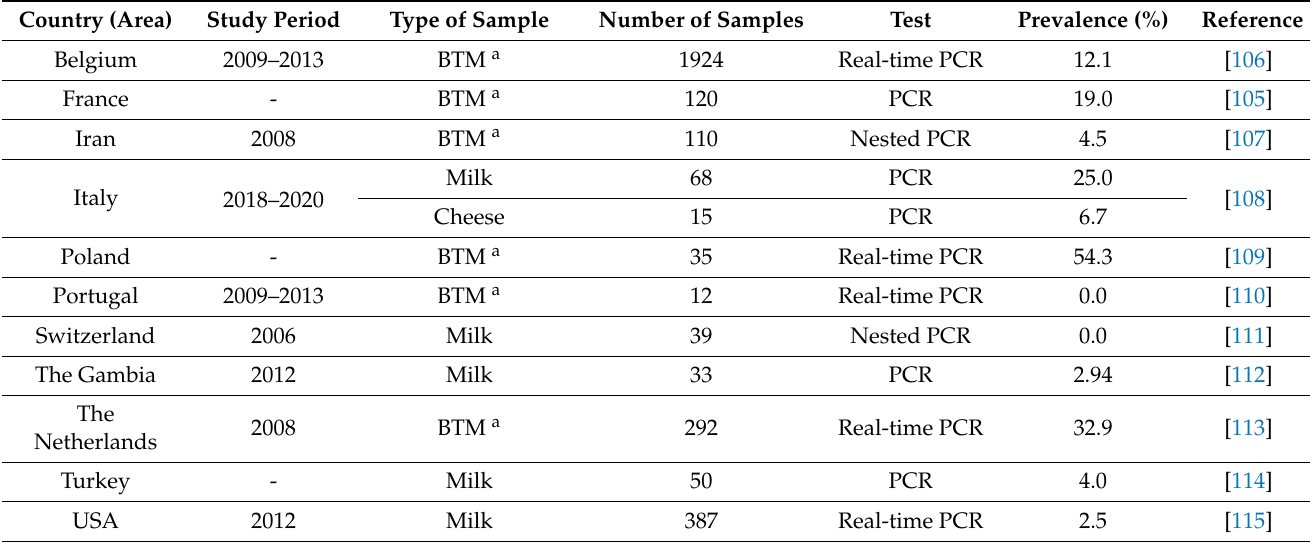
Table 2. C. burnetii DNA detected in milk samples from goat